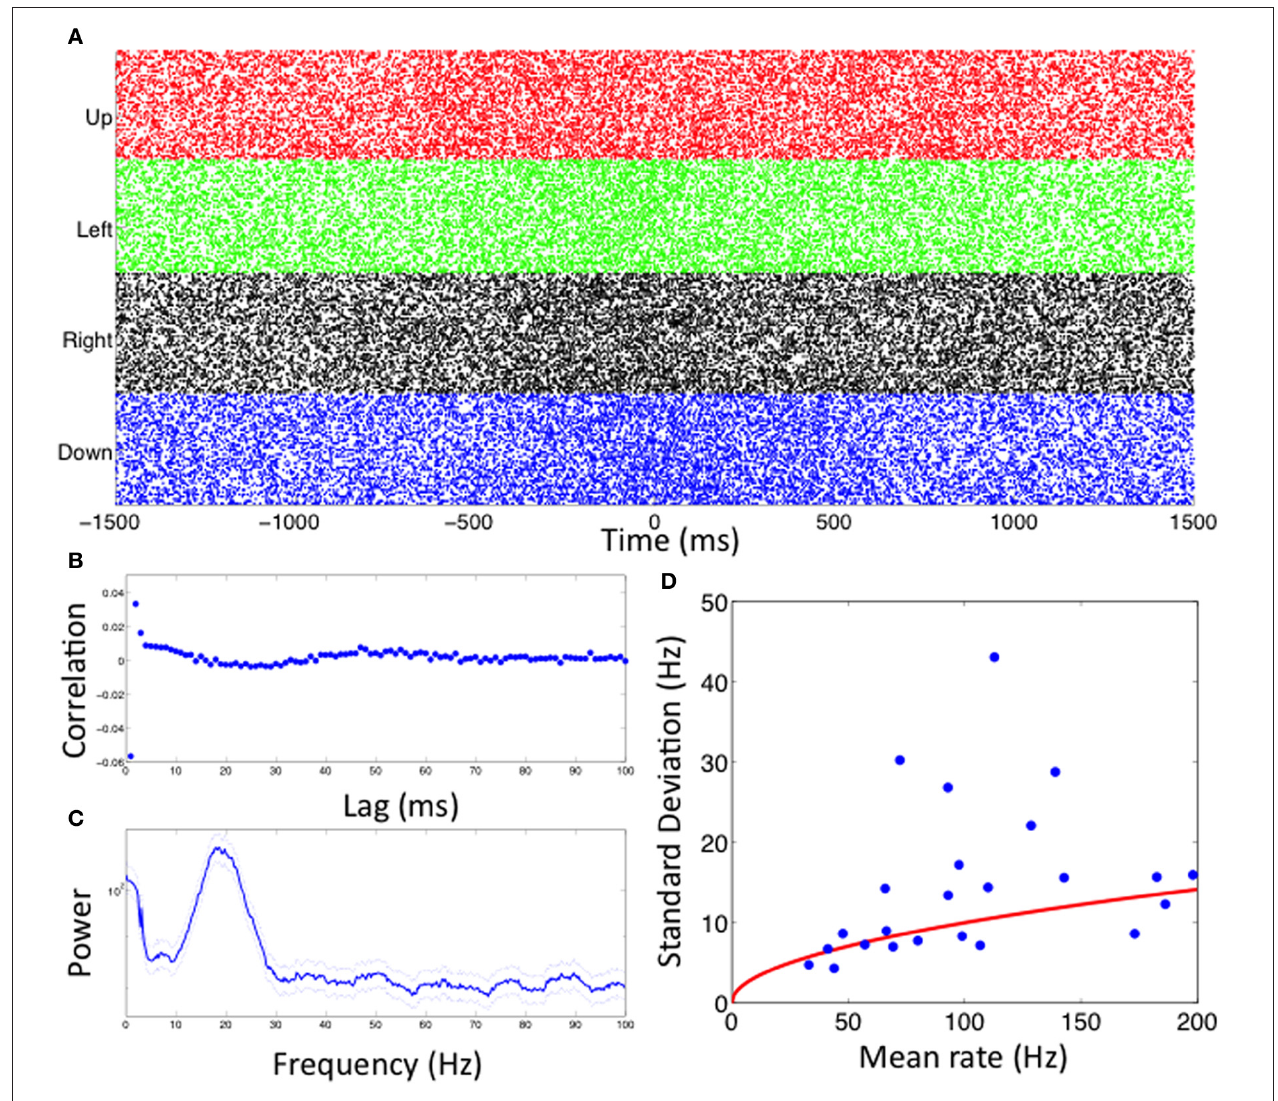
FIGURE 3 | Visualizations of spiking activity. (A–C) Spike rasters for each movement direction, spike autocorrelation function, and spike power spectral density for one example neuron. (D) Mean and